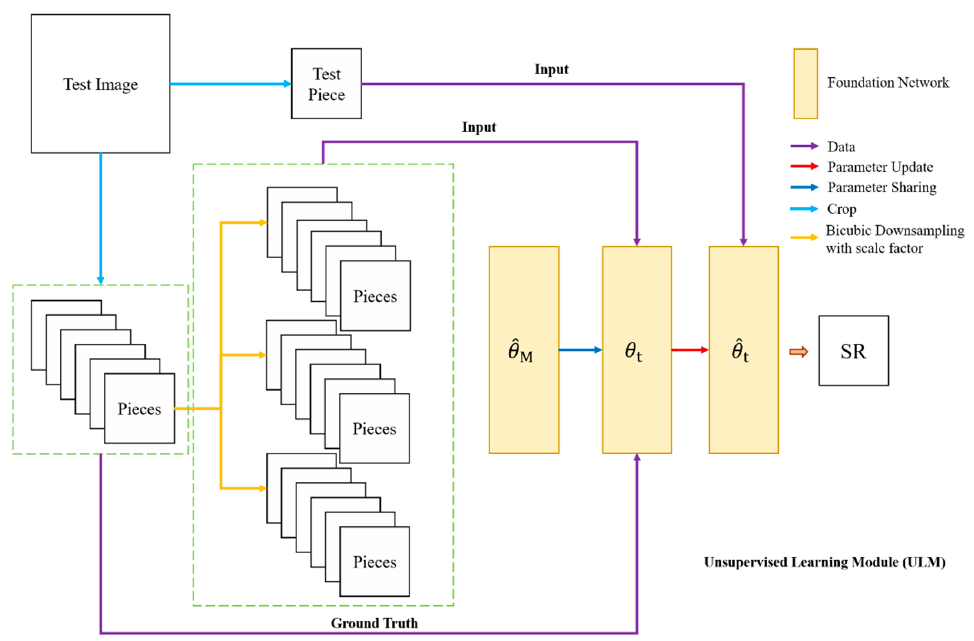
Figure 4. The framework of the unsupervised learning module (ULM).